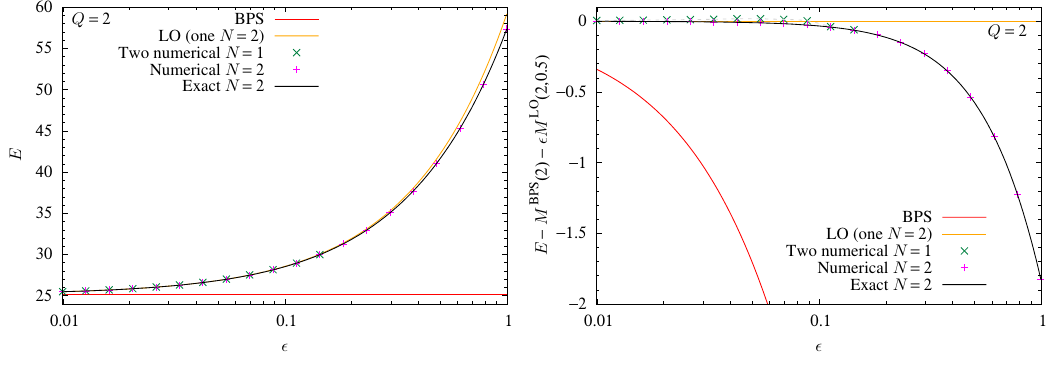
Figure 11. Left panel: energies of the baby Skyrmion solutions in the Q = 2 sector. The red line shows the BPS bound, the orange line is the LO correction for one N = 2 baby Skyrmion. The numerical solutions are: the two N = 1 Skyrmions side-by-side (green crosses), and the axially symmetric N = 2 Skyrmion (magenta pluses). The numerical N = 2 solution is compared to the exact solution (using ODE computations) shown with a black solid line. The right-hand side panel shows the same energies, but with the BPS and the LO correction subtracted off. Around (cid:15) & 0 . 15 the two N = 1 baby Skyrmions side-by-side become unstable and decay to the axially symmetric N = 2 solution — which is the stable